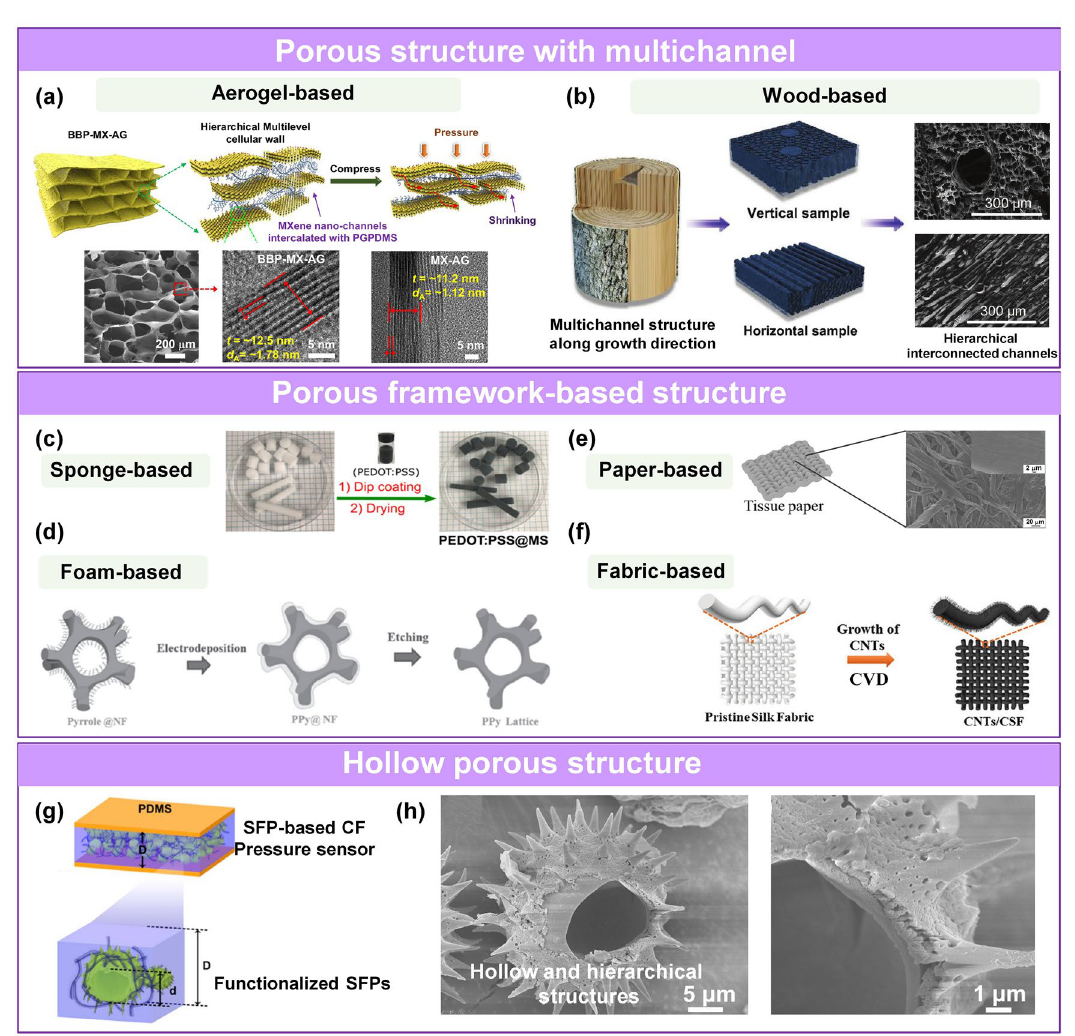
Fig. 5 Sensing materials with porous hierarchical structures. a Aerogel-based [104]. Copyright (2022) The Authors. b Wood-based porous aero- gel with nanochannels in the cellular walls [61]. Copyright (2018) Wiley–VCH. c Porous structures fabricated by coating and depositing of sponge-based [37] (Copyright (2018) American Chemical Society), d foam-based [105] (Copyright (2016) Wiley–VCH), e paper-based [34] (Copyright (2019) American Chemical Society), f fabric-based [106] (Copyright (2020) Wiley–VCH). g Piezoresistive sensor based on SFP- based CF. h SEM image of hollow hierarchical structure [225]. Copyright (2017)